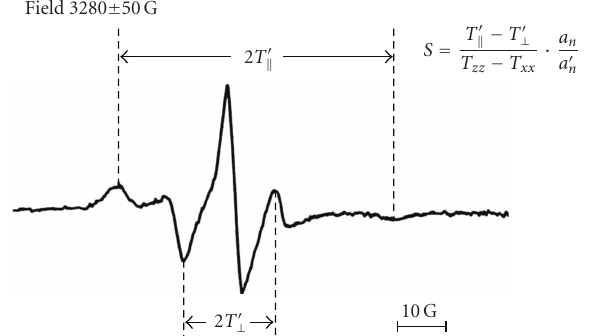
Figure 1: Representative electron spin resonance spectrum of red blood cells (RBCs) for the fatty acid spin-label agent (5-nitroxide stearate). S : order parameter, 2 T (cid:2) (cid:3) : outer hyperfine splitting, 2 T (cid:2) ⊥ : inner hyperfine splitting, T zz and T xx : hyperfine constants, a n / a (cid:2) isotropic coupling constant, G: gauss. The greater the value of the order parameter ( S ) was, the lower the membrane fluidity of RBCs